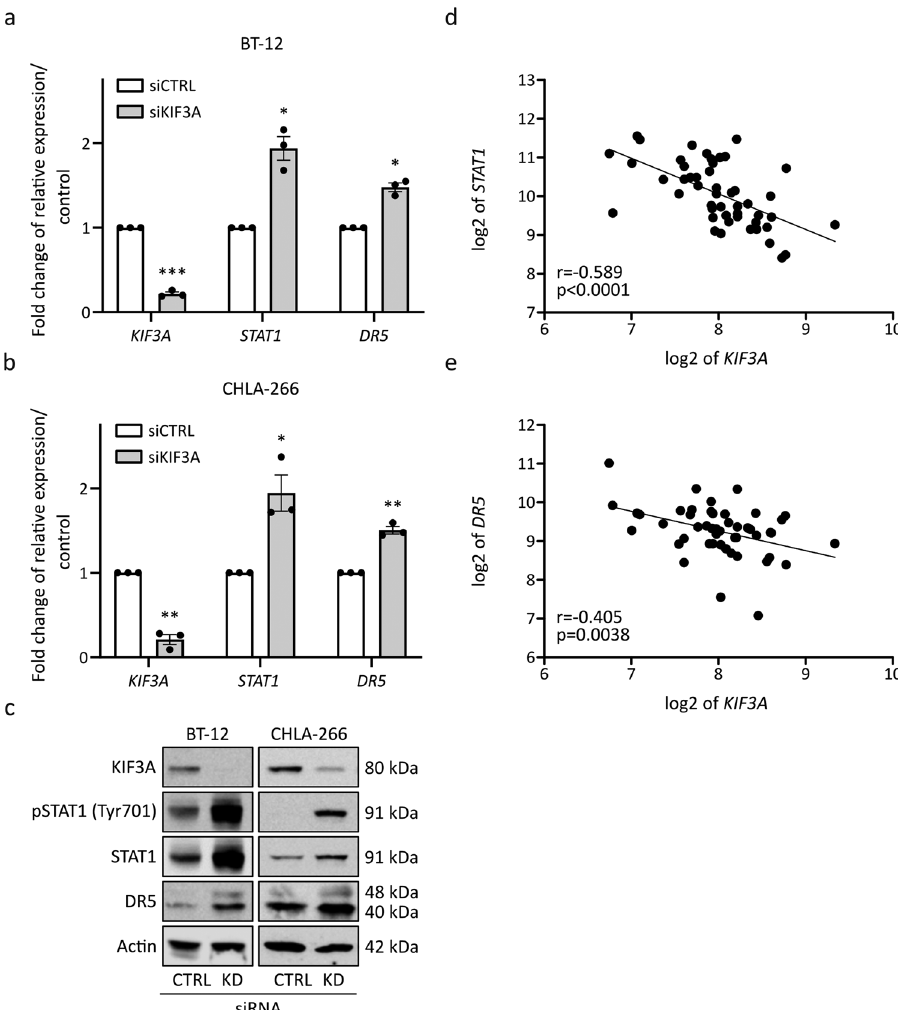
Fig. 5 Validation of upregulated signal transducer and activator of transcription 1 (STAT1) and death receptor 5 (DR5) signaling following kinesin family member 3A ( KIF3A ) knockdown in the AT/RT cell lines BT ‐ 12 and CHLA ‐ 266. a , b siRNA ‐ mediated knockdown of KIF3A in BT ‐ 12 ( a ) and CHLA ‐ 266 ( b ) cells was achieved using siPOOLs. mRNA expression was normalized to the housekeeping genes glyceraldehyde 3 ‐ phosphate dehydrogenase ( GAPDH ) and phosphoglycerate kinase 1 ( PGK1 ) and calculated relative to siCTRL. Values shown represent mean ± SEM of three biologically independent replicates. * p < 0.05; ** p < 0.01; *** p < 0.001 ( t ‐ test). c Representative Western blot images for KIF3A, pSTAT1 (Tyr701), STAT1, DR5 and actin as a loading control following siRNA ‐ mediated KIF3A knockdown. d , e Gene expression data are derived from the Tumor ATRT ‐ Kool ‐ 49 ‐ MAS5.0 ‐ u133p2 data set available at the R2: Genomics analysis and visualization platform